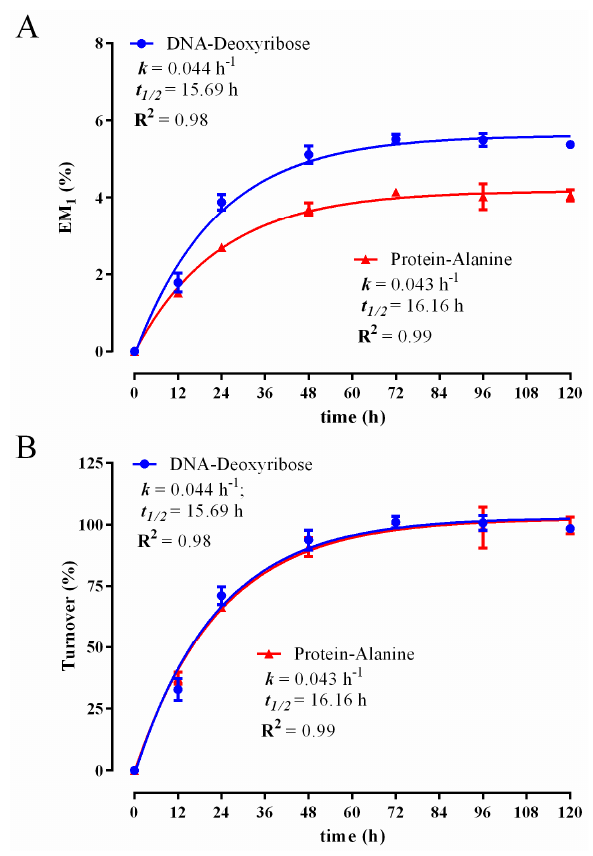
Figure 2. Time course for 2 H-incorporation into DNA-derived deoxyribose and protein-derived alanine in C2C12 myoblasts following incubation in 4% 2 H 2 O over 120 h 2 H 2 O treatment. Excess molar enrichment in the M 1 isotopomer (EM 1 ) over time in DNA-derived deoxyribose and protein-derived alanine ( A ); the percent turnover of the cellular DNA and protein pools over time ( B ). Inset: fractional synthesis rate constant ( k ), half-life ( t 1/2 ) and goodness-of-fit (R 2 ) from non-linear curve fitting. Two replicates were performed for each time point. Error bars represent the standard error of the mean